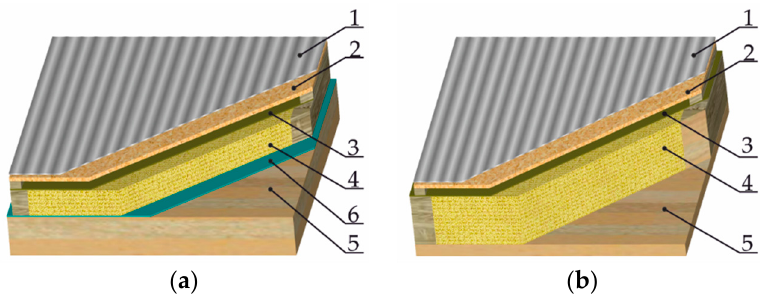
Figure 2. Typical cross-laminated timber (CLT) roof construction ( a ), modified CLT roof structure ( b ); 1—corrugated steel, 2—oriented strand board (OSB), 3—weather resistive barrier, 4—mineral wool, 5—CLT, 6—vapor retarder; (own drawing).